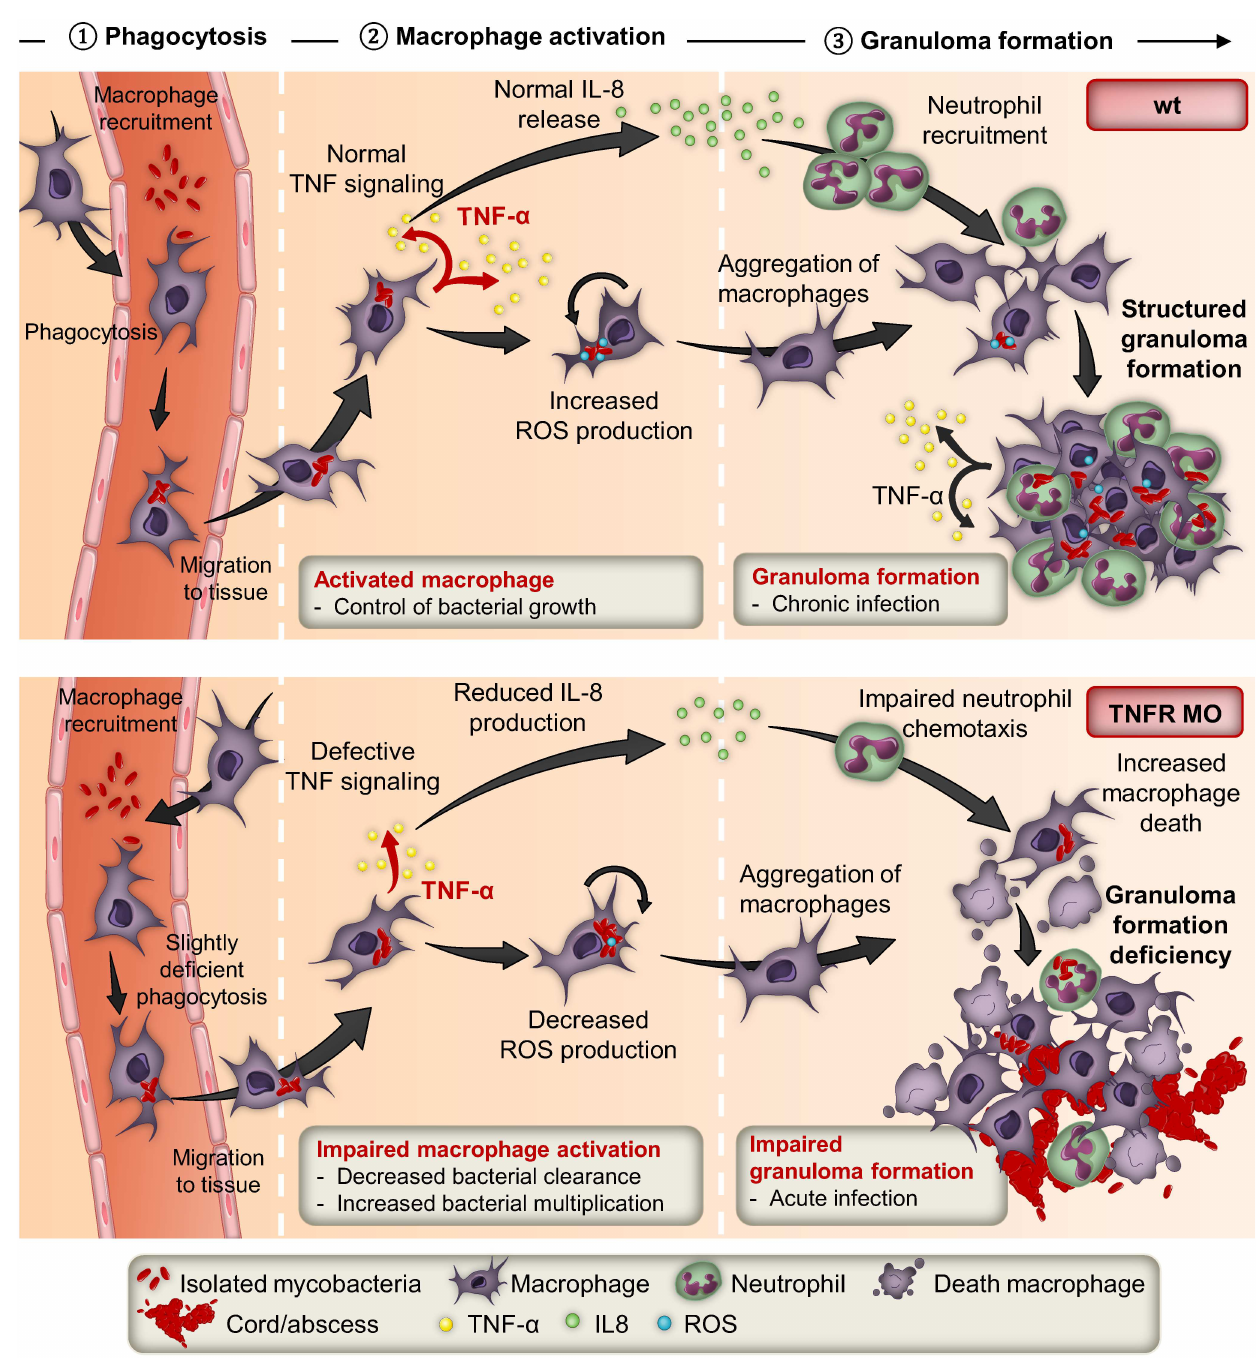
Fig 9. IL8- and TNF-dependent neutrophil mobilization in Mabs granuloma formation and immunoprotection. The upper panel summarizes the contribution of the TNF/IL8 axis in the early and late response to Mabs infection leadingto a controlledand chronic infection. The lower panel illustrates the detrimental effects of impaired TNF signalingthat, through disruptionof the IL8 production and associated defect in neutrophil mobilization, leads to impaired granuloma formation, acute infections and larval death.